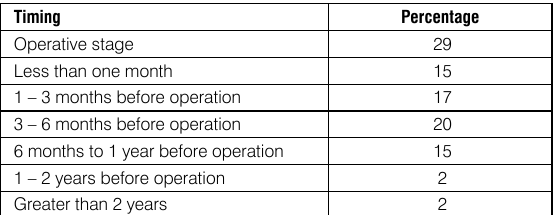
Table 2. Timing of signing of consent forms.